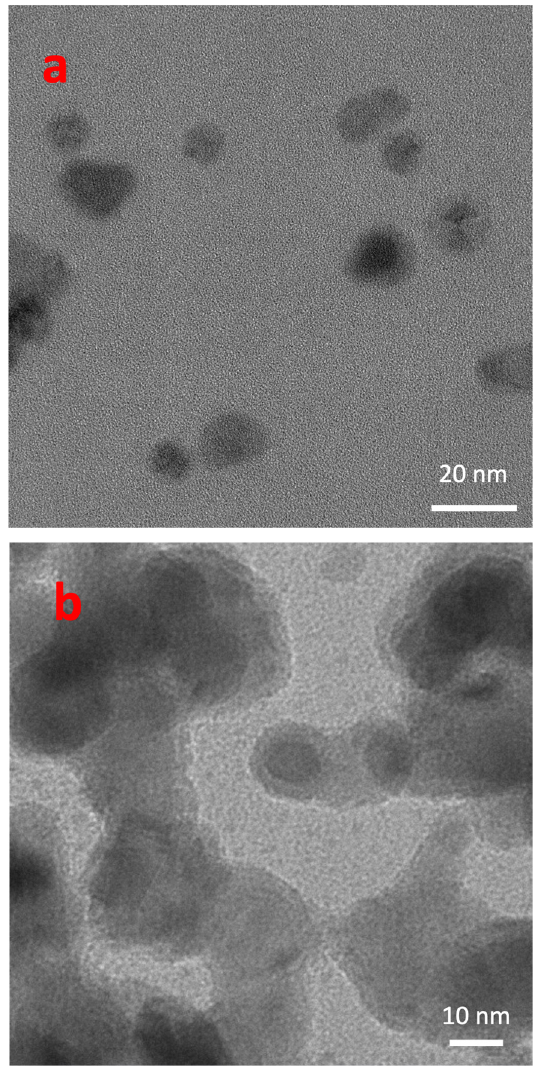
Figure 2. Bright-field TEM images of bare Cu NPs at ( a ) low coverage ( C = 2%, t = 0.2 nm) and ( b ) high coverage ( t = 6.7 nm). In this case, the fractional coverage is not a meaningful parameter, as the NPs agglomerated also along the direction normal to the surface.